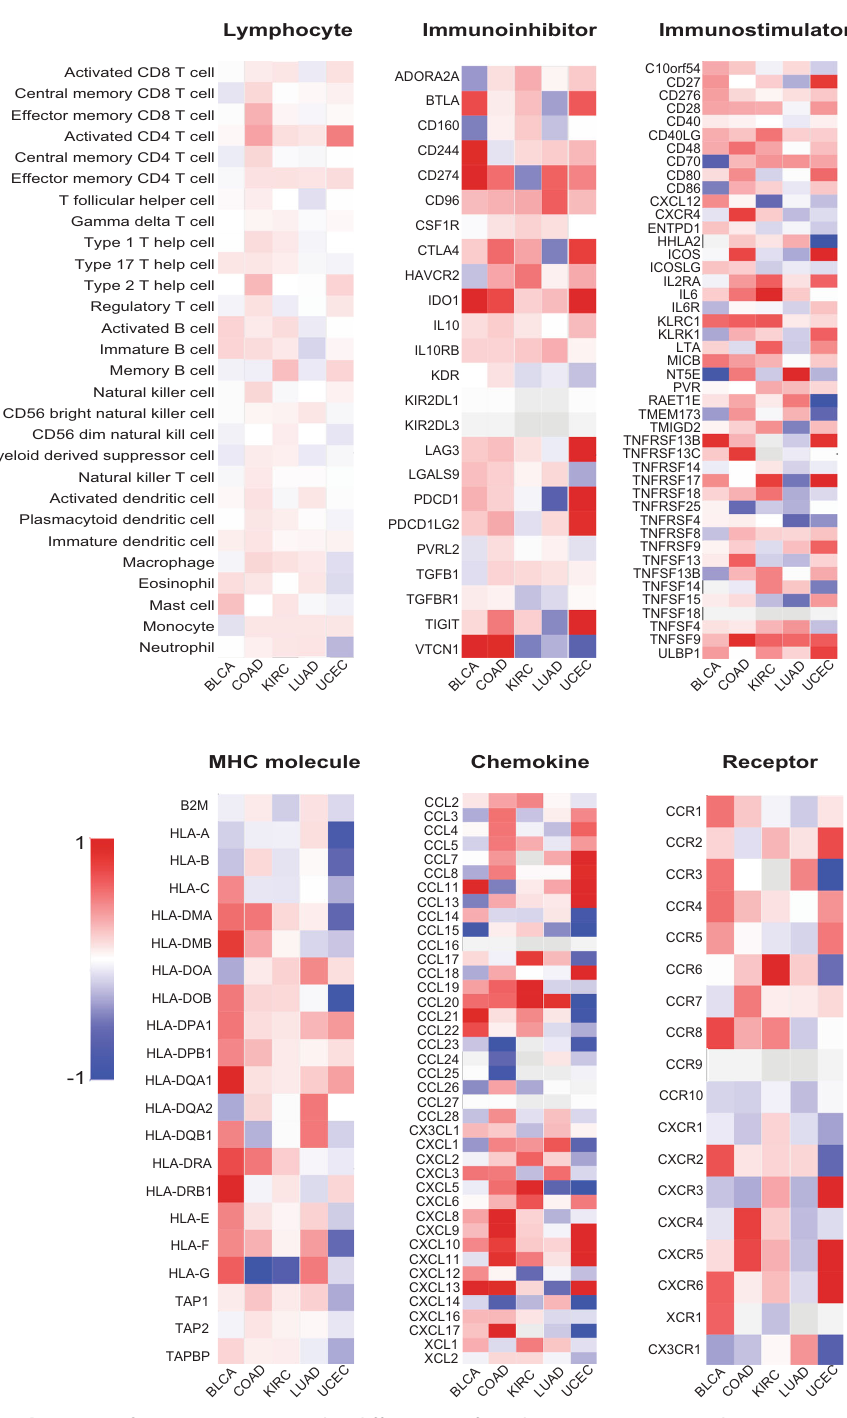
Fig. 2 SETD2 mutation and immune features in cancer. The differences of median gene expression between SETD2 mutant samples and SETD2 nonmutant samples in bladder urothelial carcinoma (BLCA), colon adenocarcinoma (COAD), kidney renal clear cell carcinoma (KIRC), lung adenocarcinoma (LUAD), and uterine corpus endometrial carcinoma OS ( P = 0.38, Fig. 1i), disease-free survival ( P = 0.53, Fig. 1j), genes were upregulated in SETD2 mutant samples, and many disease-speci fi c survival ( P = 0.76, Fig. 1k), and progress-free showed statistically signi fi cant. These results suggested the survival ( P = 0.96, Fig. 1l) between patients with SETD2 mutant immune system was more active in SETD2 mutant cancer, which cancer and patients with SETD2 nonmutant cancer. The prognosis might be recognized as immunologically “ hot ” tumor. Moreover, and survival for cancer patients in TCGA cohort were independent our data provided strong evidence that cancer epigenetic driver of SETD2 mutant status. mutations could shape tumor immune phenotype. Previous studies suggested that copy number alteration (CNA) To investigate whether these distinct characterisitics of SETD2 of SETD2 contributed to the mutation could translate into cancer prognosis, we compared the